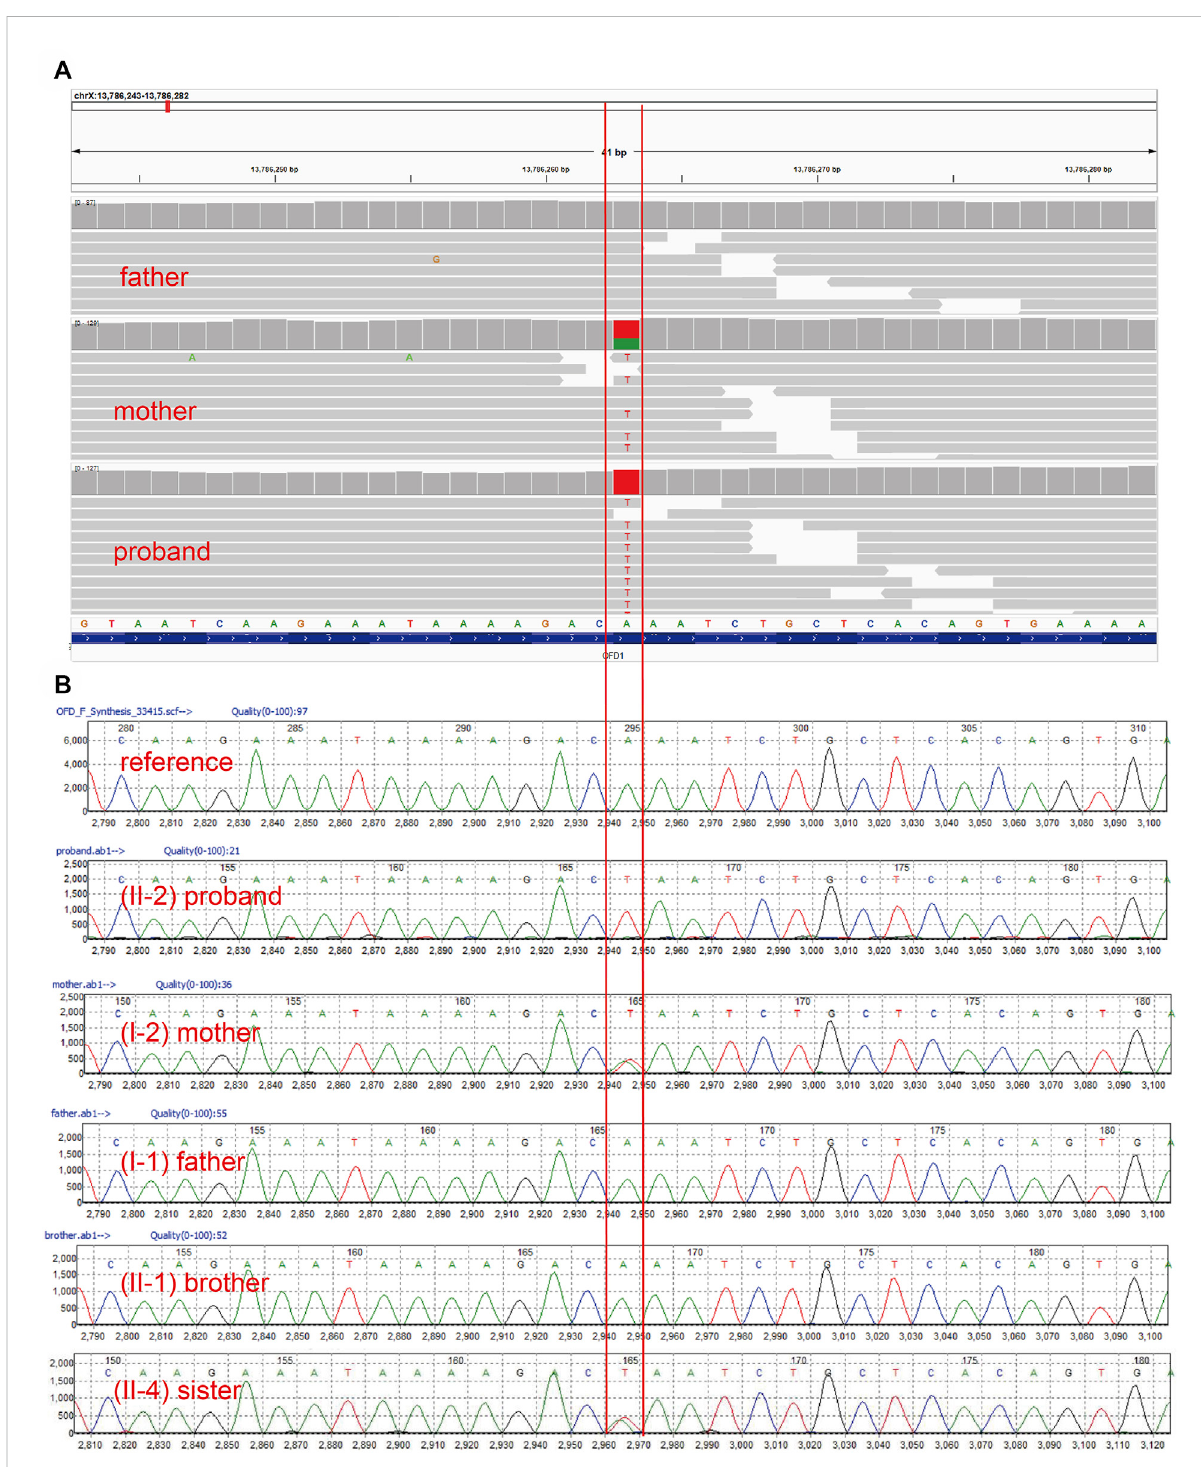
FIGURE 2 Genetic fi ndings. (A) . WES detected a hemizygous variant c.2848A > T (p.Lys950Ter) of the OFD1 gene in the index fetus, which was heterozygous in the mother and absent in the father. (B) . Sanger DNA sequencing chromatogram showed the cosegregation of this variant in all family